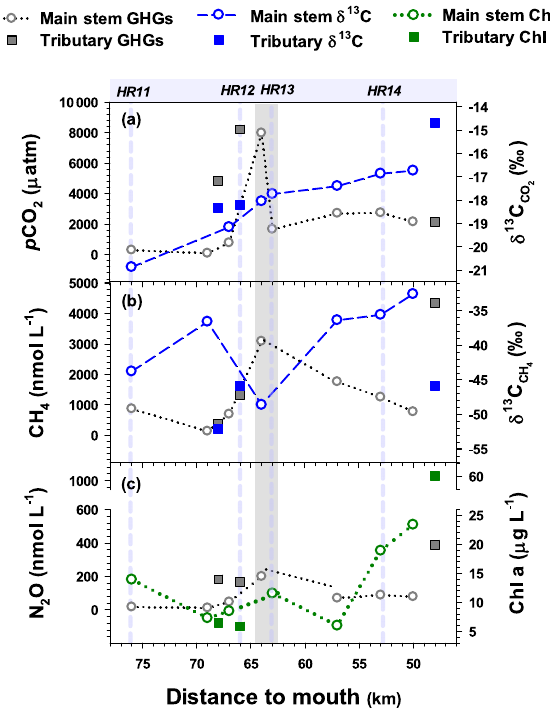
Figure 8. Spatial variations in p CO 2 and δ 13 C CO (a) , CH 4 con- 2 (b) , and N 2 O and Chl a concentrations (c) centrations and δ 13 C CH 4 measured at 8 main stem sites and 3 urban tributary outlets during a cruise expedition (June 2016) along the lower reach of the Han River. The grey shaded area indicates the main stem section receiv- ing the inflow from the urban tributary JN (HR12). The four vertical dashed lines denote the locations of the four monthly monitoring sites along the lower reach. Data of p CO 2 and δ 13 C CO were mod- 2 ified from Yoon et al.